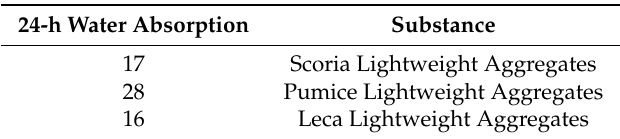
Table 6. The water absorption of natural and synthetic lightweight aggregates in accordance with ISO 7782